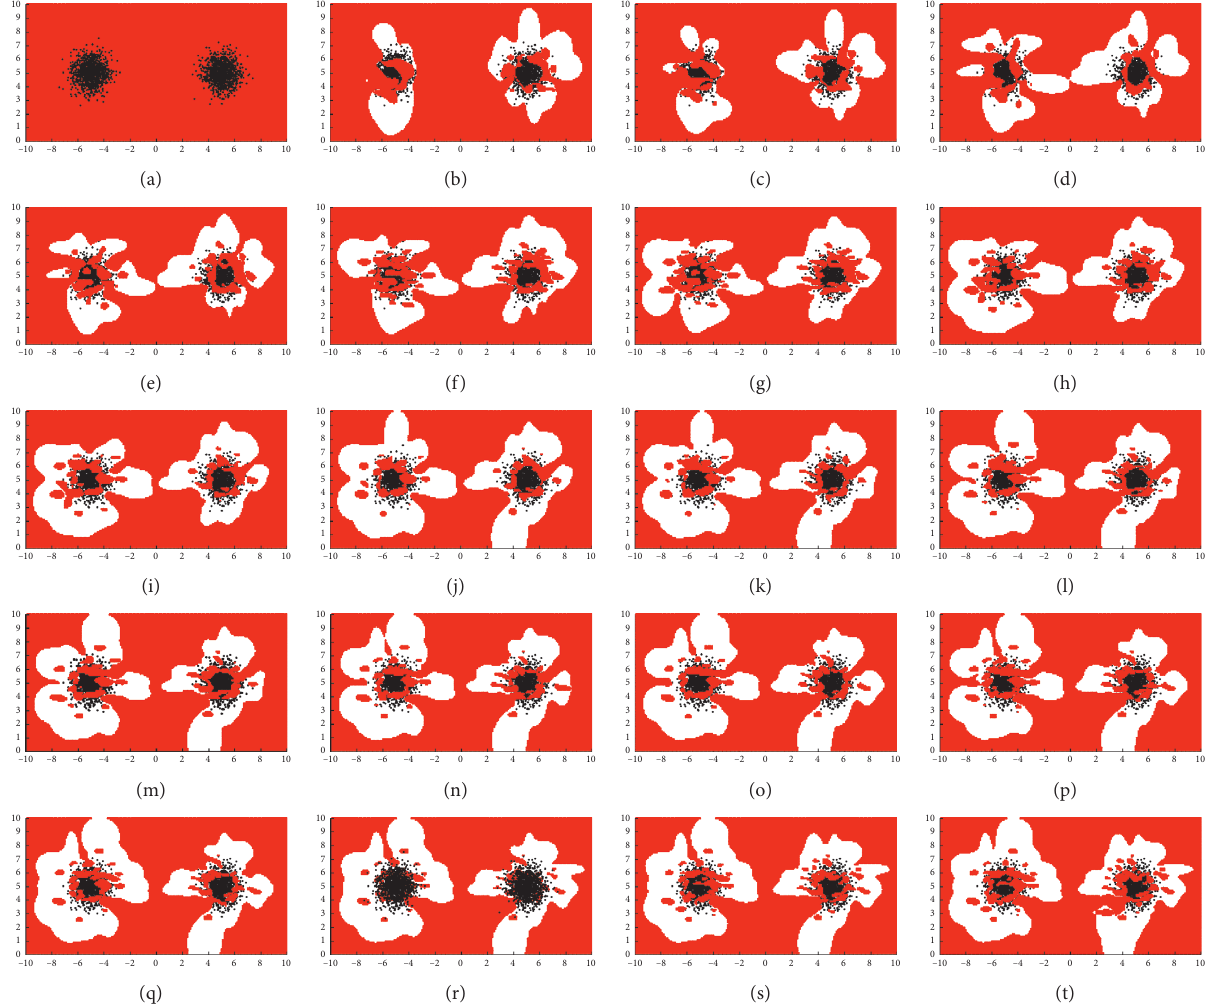
Figure 6: The convergence tendency of the I-KDE on 2-dimensional bimodal normal distribution (the value in the parenthesis is the win ratio of the I-KDE). (a) 1 data block (1.000). (b) 2 data blocks (0.783). (c) 3 data blocks (0.790). (d) 4 data blocks (0.739). (e) 5 data blocks (0.748). (f) 6 data blocks (0.727). (g) 7 data blocks (0.705). (h) 8 data blocks (0.675). (i) 9 data blocks (0.672). (j) 10 data blocks (0.613). (k) 11 data blocks (0.625). (l) 12 data blocks (0.626). (m) 13 data blocks (0.634). (n) 14 data blocks (0.628). (o) 15 data blocks (0.621). (p) 16 data blocks (0.638). (q) 17 data blocks (0.620). (r) 18 data blocks (0.614). (s) 19 data blocks (0.610). (t) 20 data blocks (0.604). Table 2: The comparison between the KDE and I-KDE on 10 univariate and 4 multivariate distributions. # Probability distribution Training samples Testing space Testing